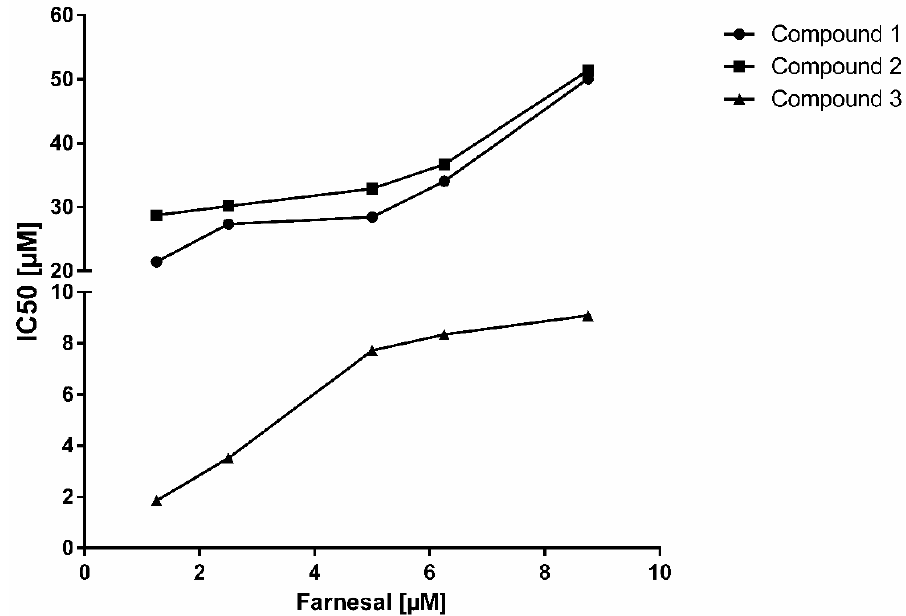
Figure 3. IC 50 -values of the isolated hop compounds for AKR1B10-catalysed farnesal reduction as a function of substrate concentration [compound 1 (adhumulone) (circles), compound 2 (cohumulone) (squares) and compound 3 ( n -humulone) (triangles)].